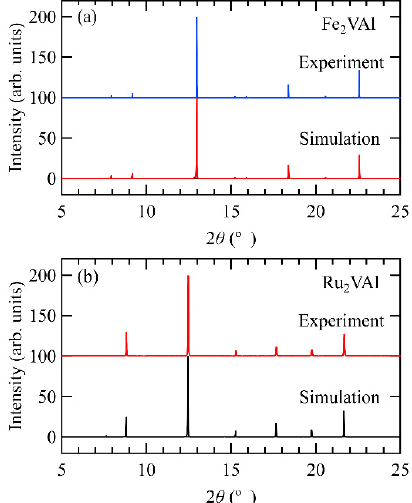
Figure 3. Powder X-ray diffraction patterns for Fe 2 VAl ( a ) and Ru 2 VAl ( b ).